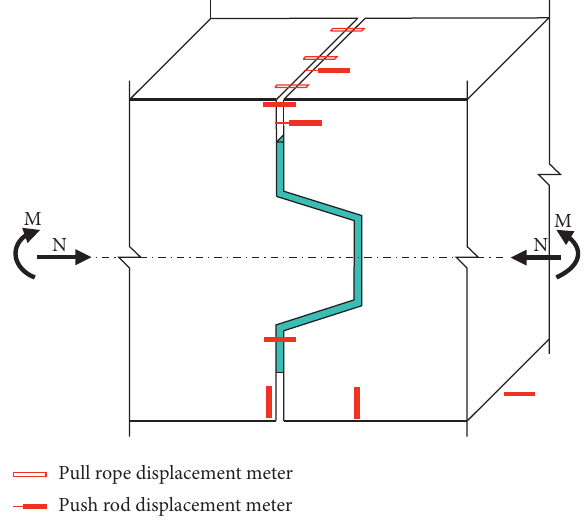
Figure 4: Location of displacement